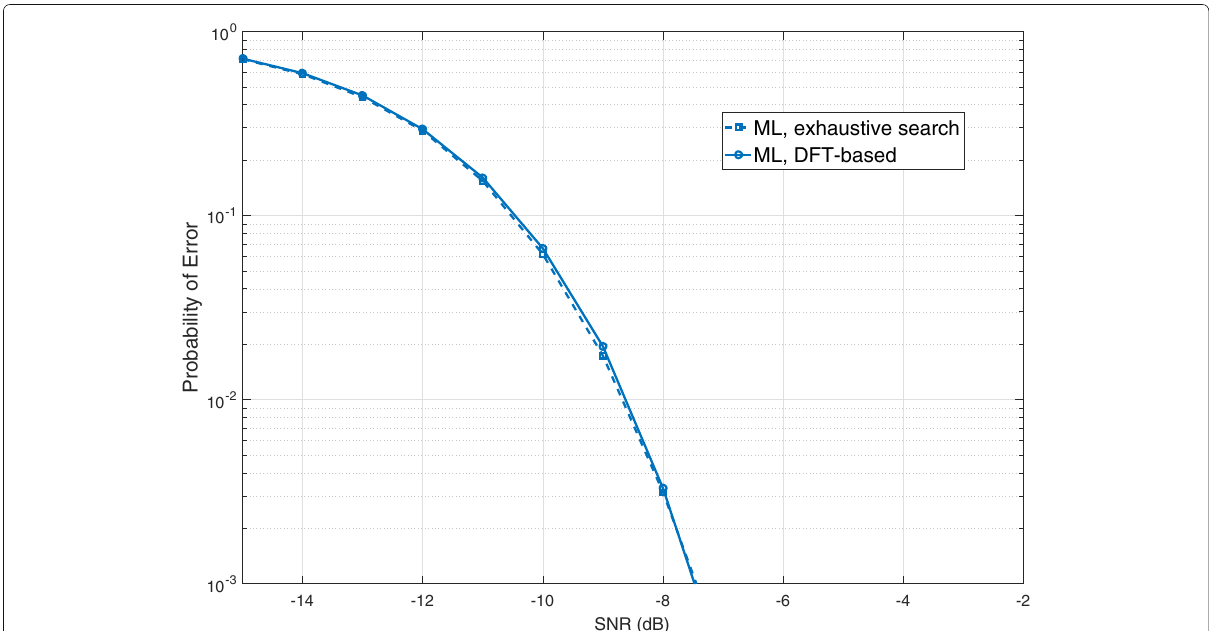
Fig. 3 Error probability versus SNR (dB) of cell ID ML estimator using (9) and the suggested DFT-based implementation (15). A known channel is assumed